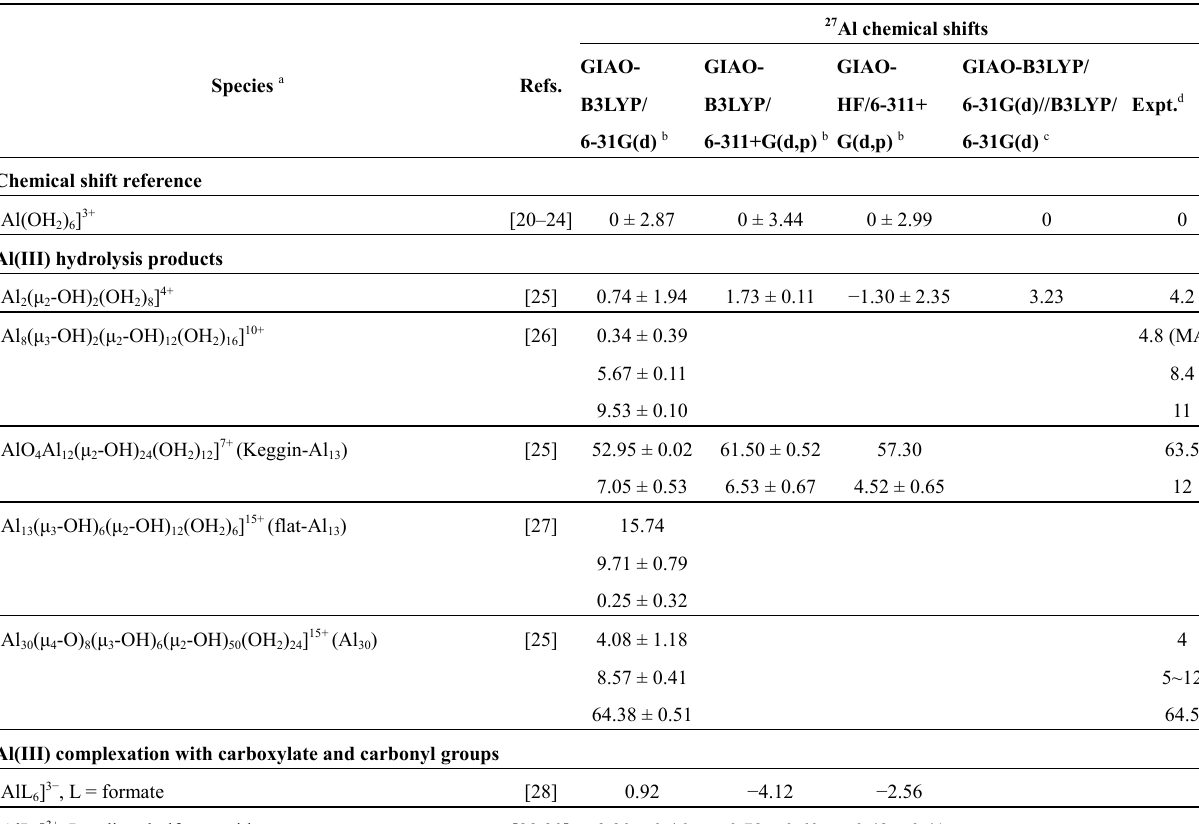
27 Al chemical shifts GIAO- GIAO- B3LYP/ Expt. B3LYP/ 6-31G(d) b